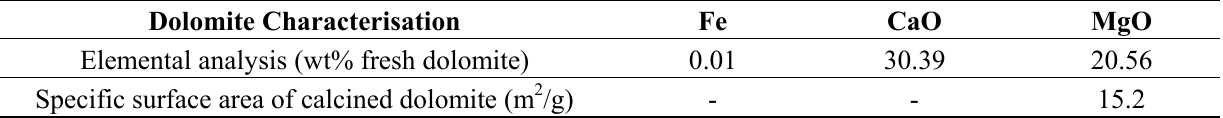
Table 1. Elemental analysis of fresh dolomite; and specific surface area of calcined dolomite. Dolomite Characterisation Elemental analysis (wt% fresh